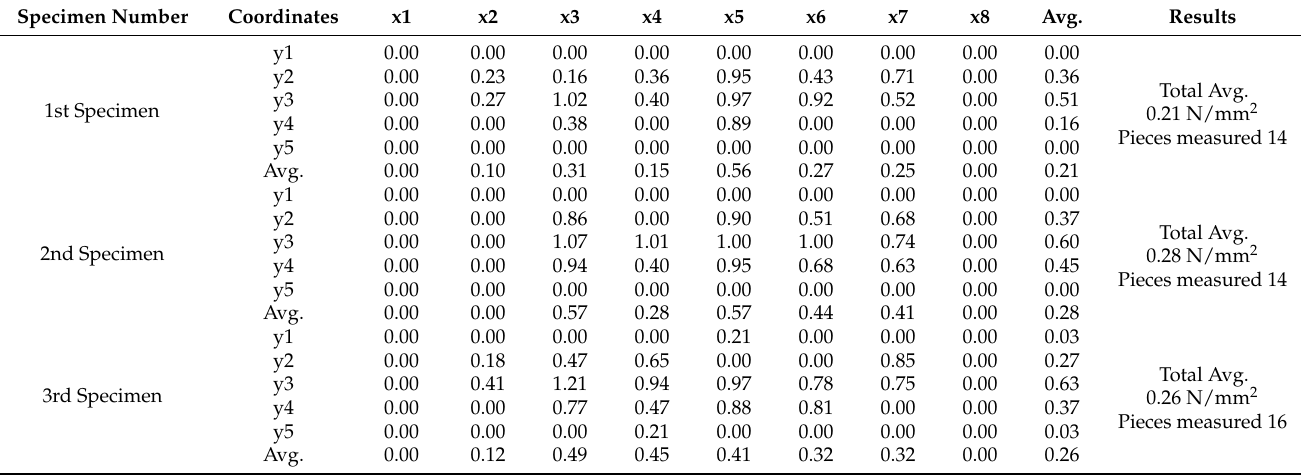
Table 7. AR 60 ± 2% specimen